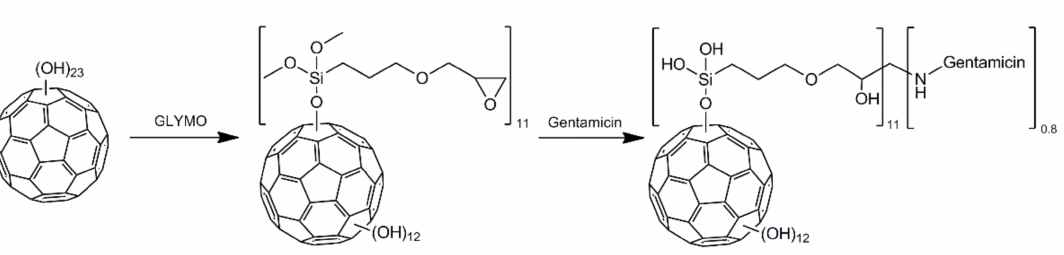
Figure 7. Scheme for synthesis of gentamicin functionalized C 60 fullerene ( 60FGG ) using fullerenol as a